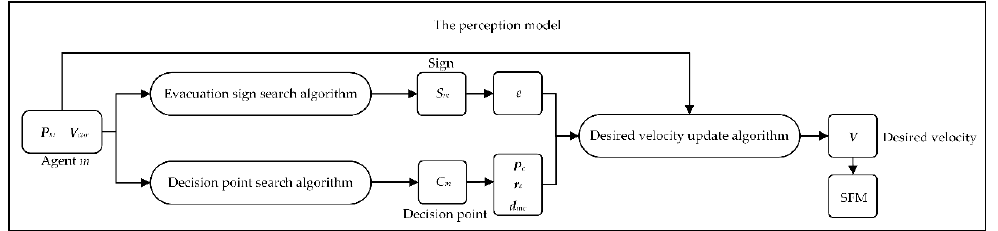
Figure 5. Framework of the perception model.